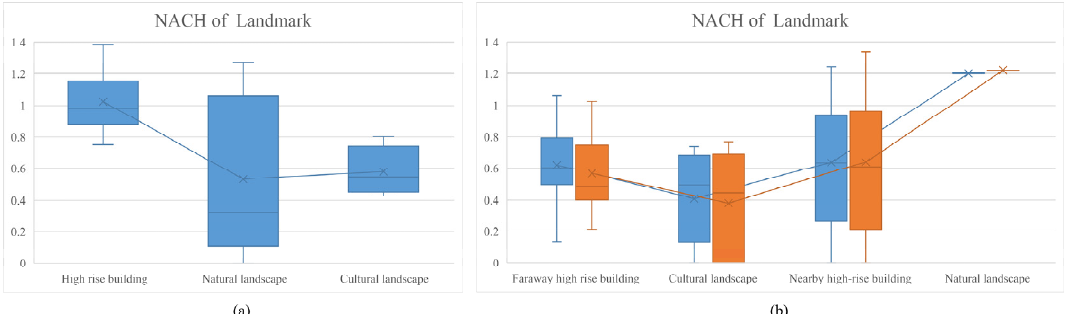
Figure 16. Boxplot analysis of NACH values for various types of landmarks. ( a ) TP-District; ( b ) XD- District. Table 4. Standard deviations of NACH values for each type of landmark.